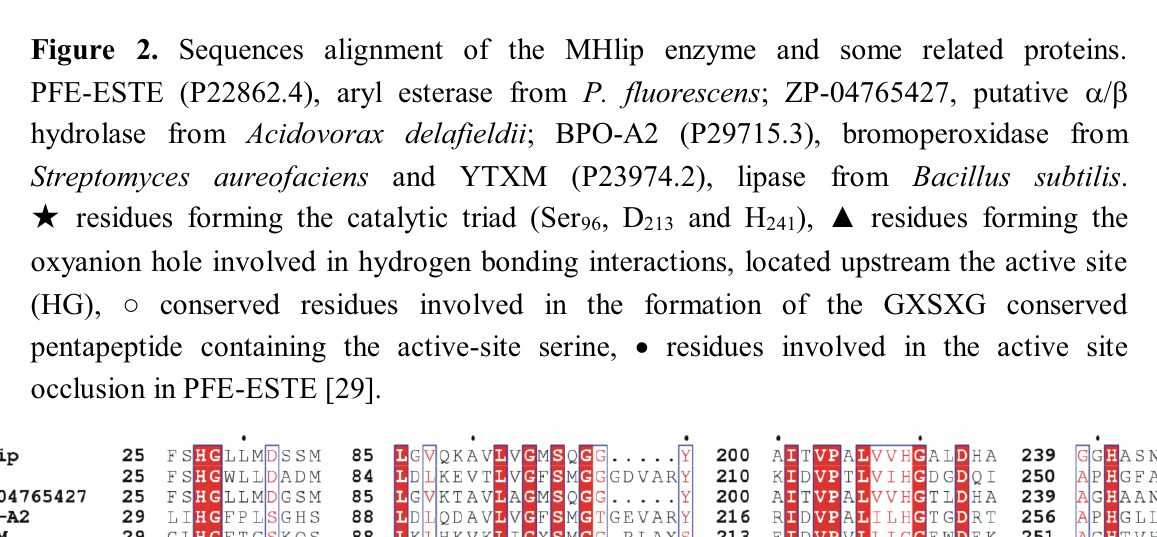
Figure 2. Sequences alignment of the MHlip enzyme and some related proteins. PFE-ESTE (P22862.4), aryl esterase from P. fluorescens ; ZP-04765427, putative (cid:68) / (cid:69) hydrolase from Acidovorax delafieldii ; BPO-A2 (P29715.3), bromoperoxidase from Streptomyces aureofaciens and YTXM (P23974.2), lipase from Bacillus subtilis .